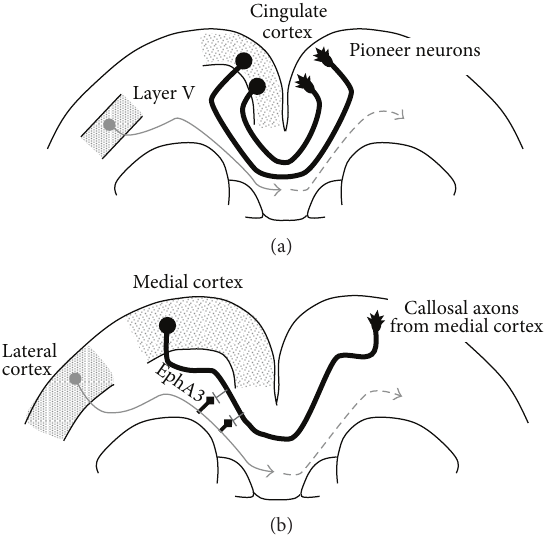
Figure 3: Axon-axon interactions in the development of callosal axons. (a) Navigation of callosal axons by “pioneer” neurons. Pioneer neurons, which are located in the region extending from the presumptive cingulate cortex to the hippocampus, first extend their axons to form the path of the commissural axons. Then, on E17.0, the most early “follower” axons originating from layer V follow the pioneer neurons. (b) Interaction between the medial and lateral cortex-derived callosal axons through EphA3. The axons from the medial (roughly corresponding to the cingulate, motor and medial part of the primary somatosensory cortices) and lateral cortices (roughly corresponding to the areas around the secondary somatosensory cortex) pass through the dorsal and ventral half of theCC,respectively.Repulsiveeffectsbetweenthemedialandlateral cortical axons contribute to their correct pathfinding in the CC. EphA3 expressed on the lateral axons mediates, at least in part, this interaction between the medial and lateral